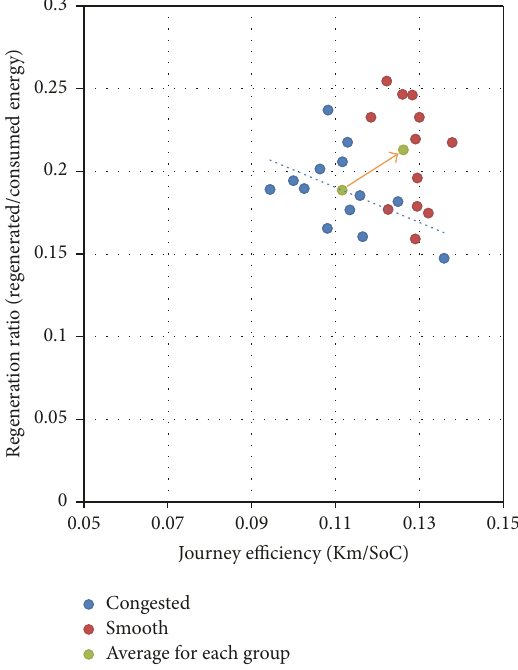
Figure 6: Regeneration ratio versus journey energy efficiency by traffic